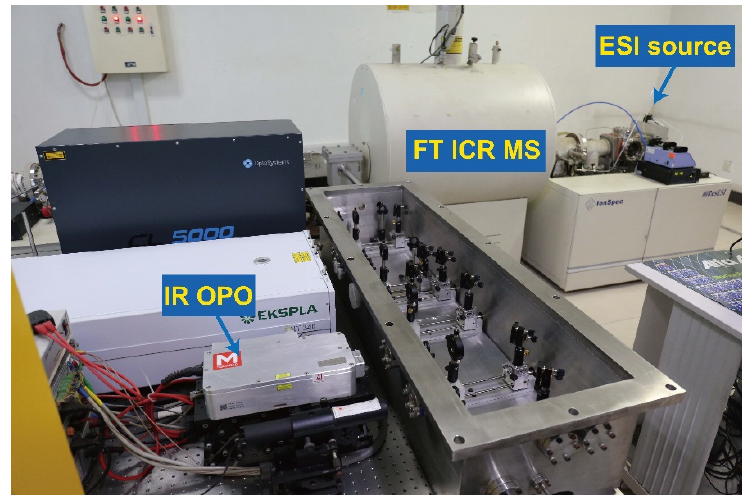
Figure 2. The experimental setup for IRMPD experiments in Nankai University, based on a 7 T FT ICR mass spectrometer (Ionspec) and a tunable optical parametric oscillator (OPO) laser (Msquares).